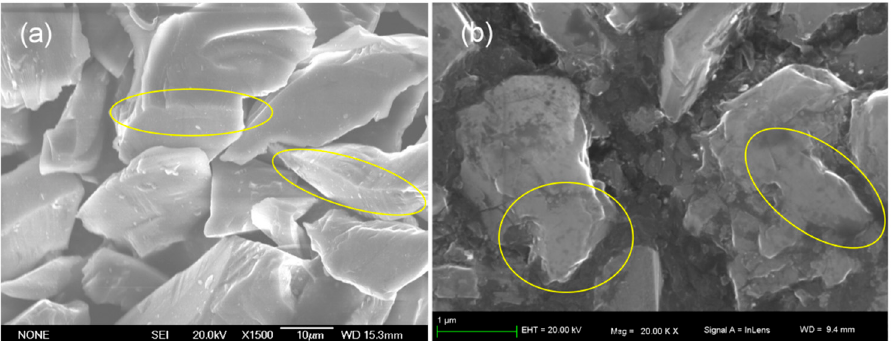
Figure 5. SEM images of ex situ SiC particles and in situ SiC particles: ( a ) Ex situ SiC particles, ( b ) In situ SiC particles.